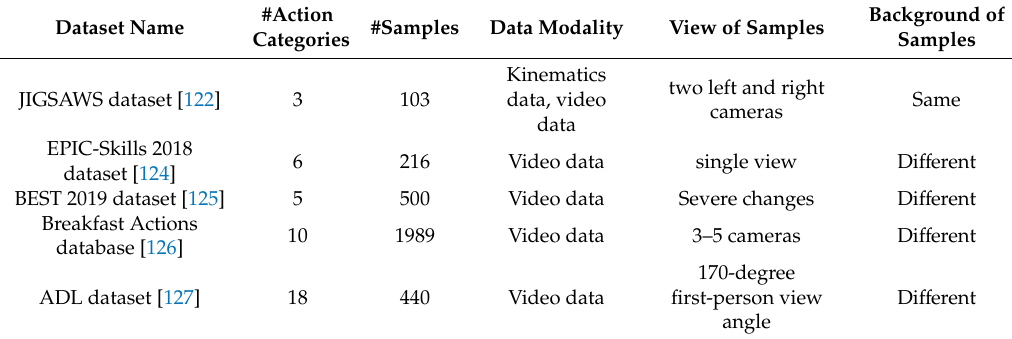
Table 4. Skill training-related